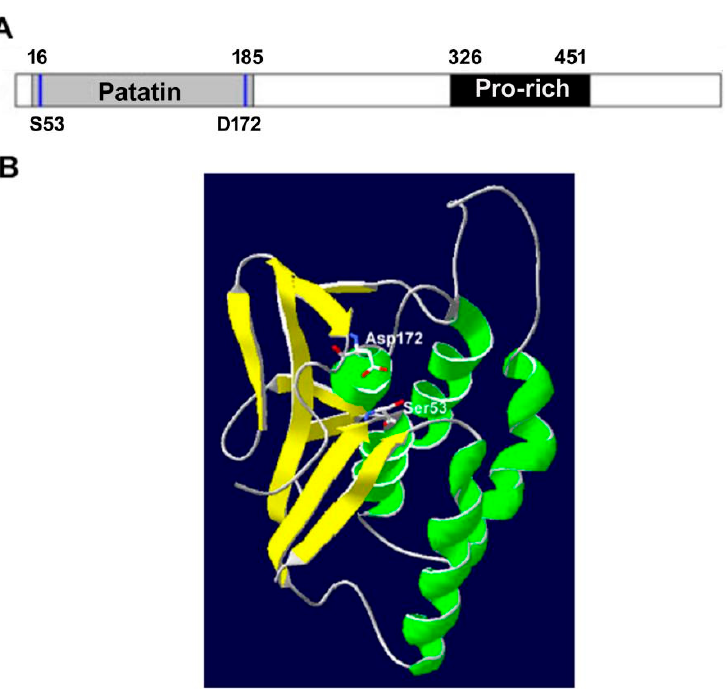
Figure 1. Protein domains of the human PNPLA1. ( A ) Patatin domain (aa 16 ‐ 185) and a proline ‐ rich hydrophobic region (aa 326–451) were present in the N ‐ and C ‐ terminal regions, respectively. S53 and D172 represent the conserved catalytic residues of serine and aspartate in the patatin domain. ( B ) Molecular model of the patatin domain of human PNPLA1. Regions predicted to fold as β‐ sheets and α‐ helices are shaded yellow and green, respectively. Side chains of the active sites, Asp172 and Ser53, are rendered in stick format and the atoms colored using standard Corey, Pauling and Kultun (CPK).